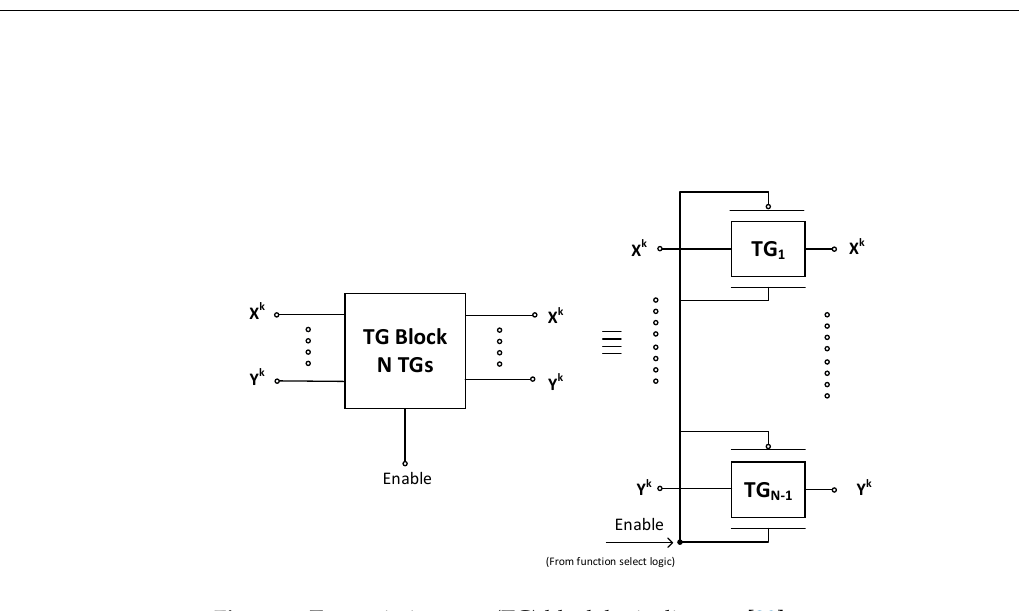
Figure 4. Transmission gate (TG) block logic diagram